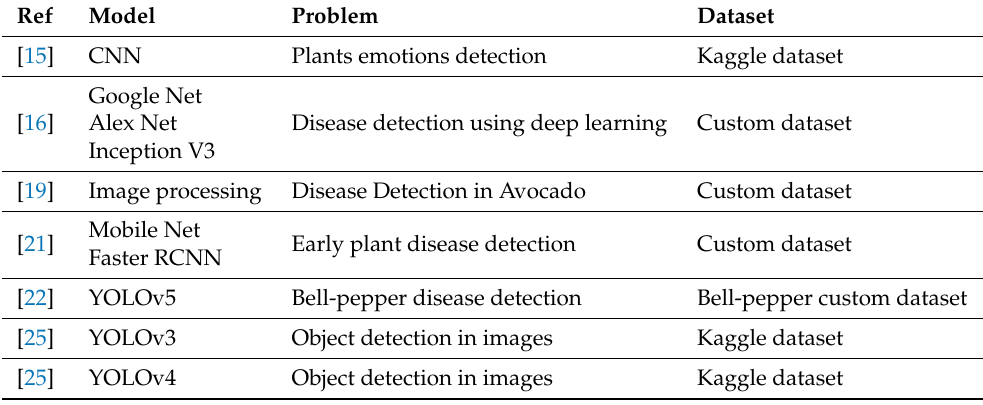
Table 2. Comparative Analysis of Selected